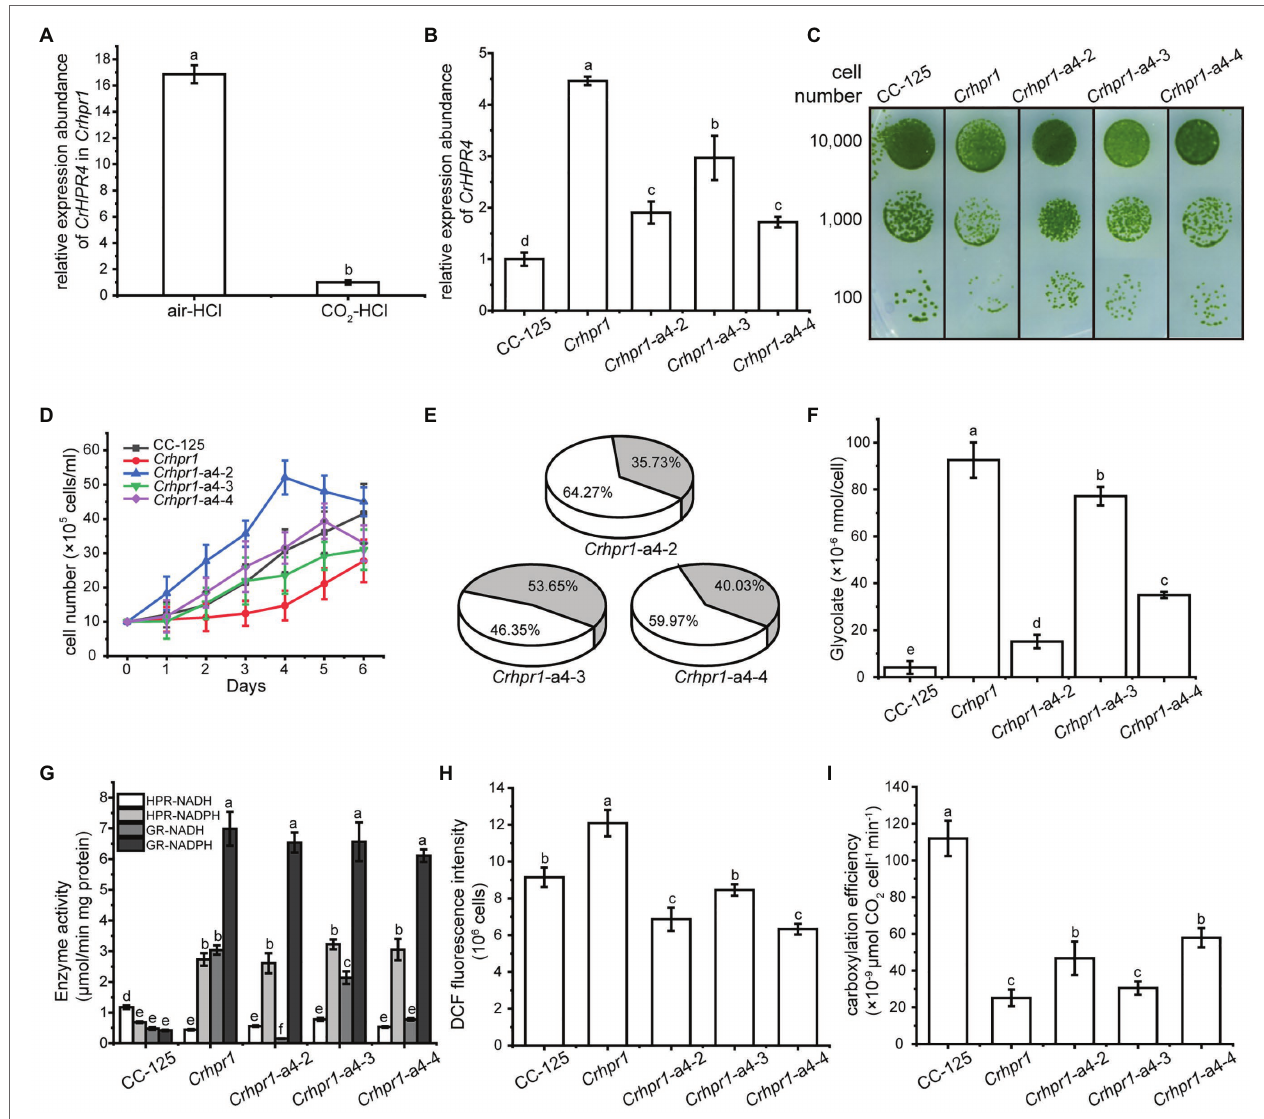
FIGURE 5 | CrHPR4 participates in photorespiration as a chloroplast-targeting glyoxylate reductase. (A) Measurement of CrHPR4 transcripts at both WT/CC-125 and Crhpr1 background in air condition. (B) Measurement of CrHPR4 transcripts in Crhpr1 and Crhpr1-a2 strains. (C) Spot tests showing growth of Crhpr1 and Crhpr1-a4 strains. (D) Growth curves of Crhpr1 and Crhpr1-a4 strains. (E) The ratio of oxidation and carboxylation reaction of Rubisco in Crhpr1-a4 strains. Carboxylation reaction: white sector. Oxidation reaction: gray sector. (F) Concentration of glycolate detected in the medium of each strain. (G) Enzyme activity assay of Crhpr1 and Crhpr1-a4 strains. HPR-NADH: white bars. HPR-NADPH: light gray bars. GR-NADH: gray bars. GR-NADPH: dark gray bars. (H) Determination of reactive oxygen species (ROS) in Crhpr1 and Crhpr1-a4 strains treated with salicylhydroxamic acid. (I) Determination of carboxylation efficiency in Crhpr1 and Crhpr1-a4 strains treated with salicylhydroxamic acid. Mean values ± SD from three measurements. Means denoted by the same letter did not significantly differ at p <